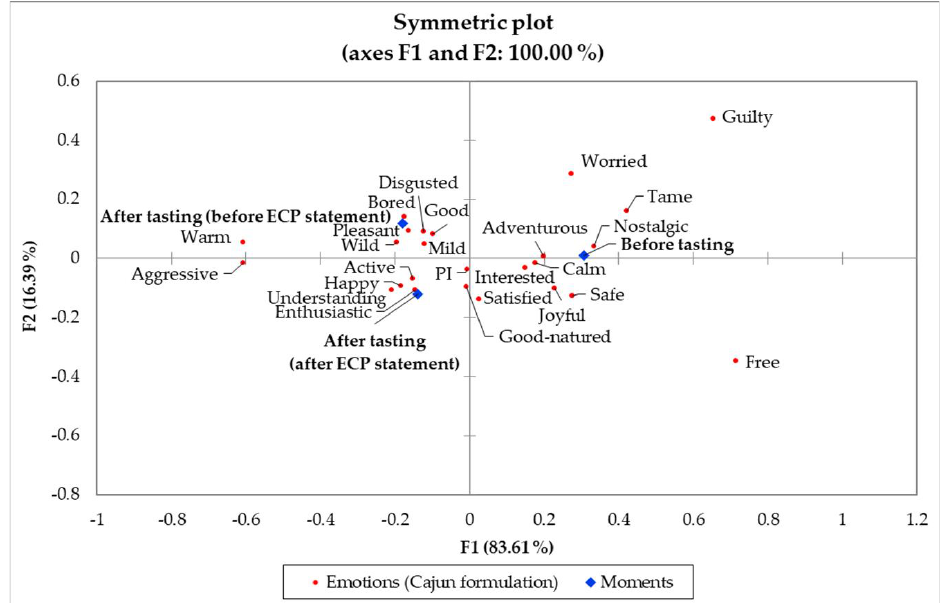
Figure 6. Correspondence analysis (chi-squared distance) symmetric plot visualizing the Cajun treatment moments (before tasting, after tasting, and after edible cricket protein (ECP) statement) and emotions from n = 84 consumers. Treatments are described in Figure 1.